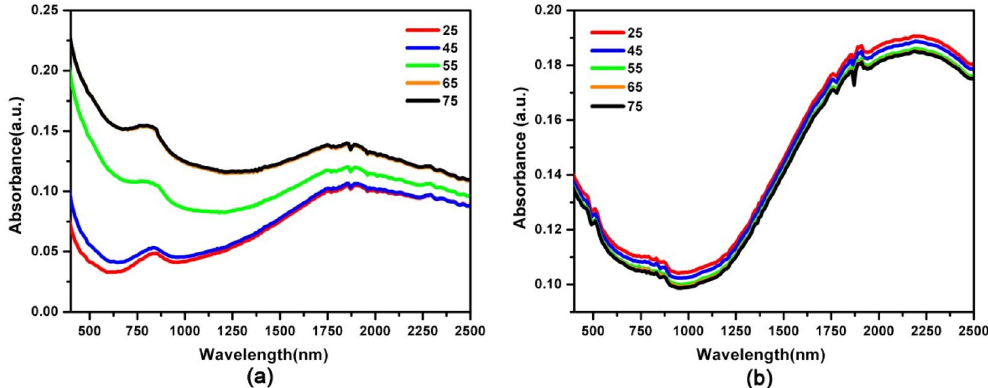
Figure 4. Absorption spectra of ( a ) ITO-NC@copolymer/PCL (INCP) films and ( b ) ITO-NC@ copolymer films at between 25–75 °C.